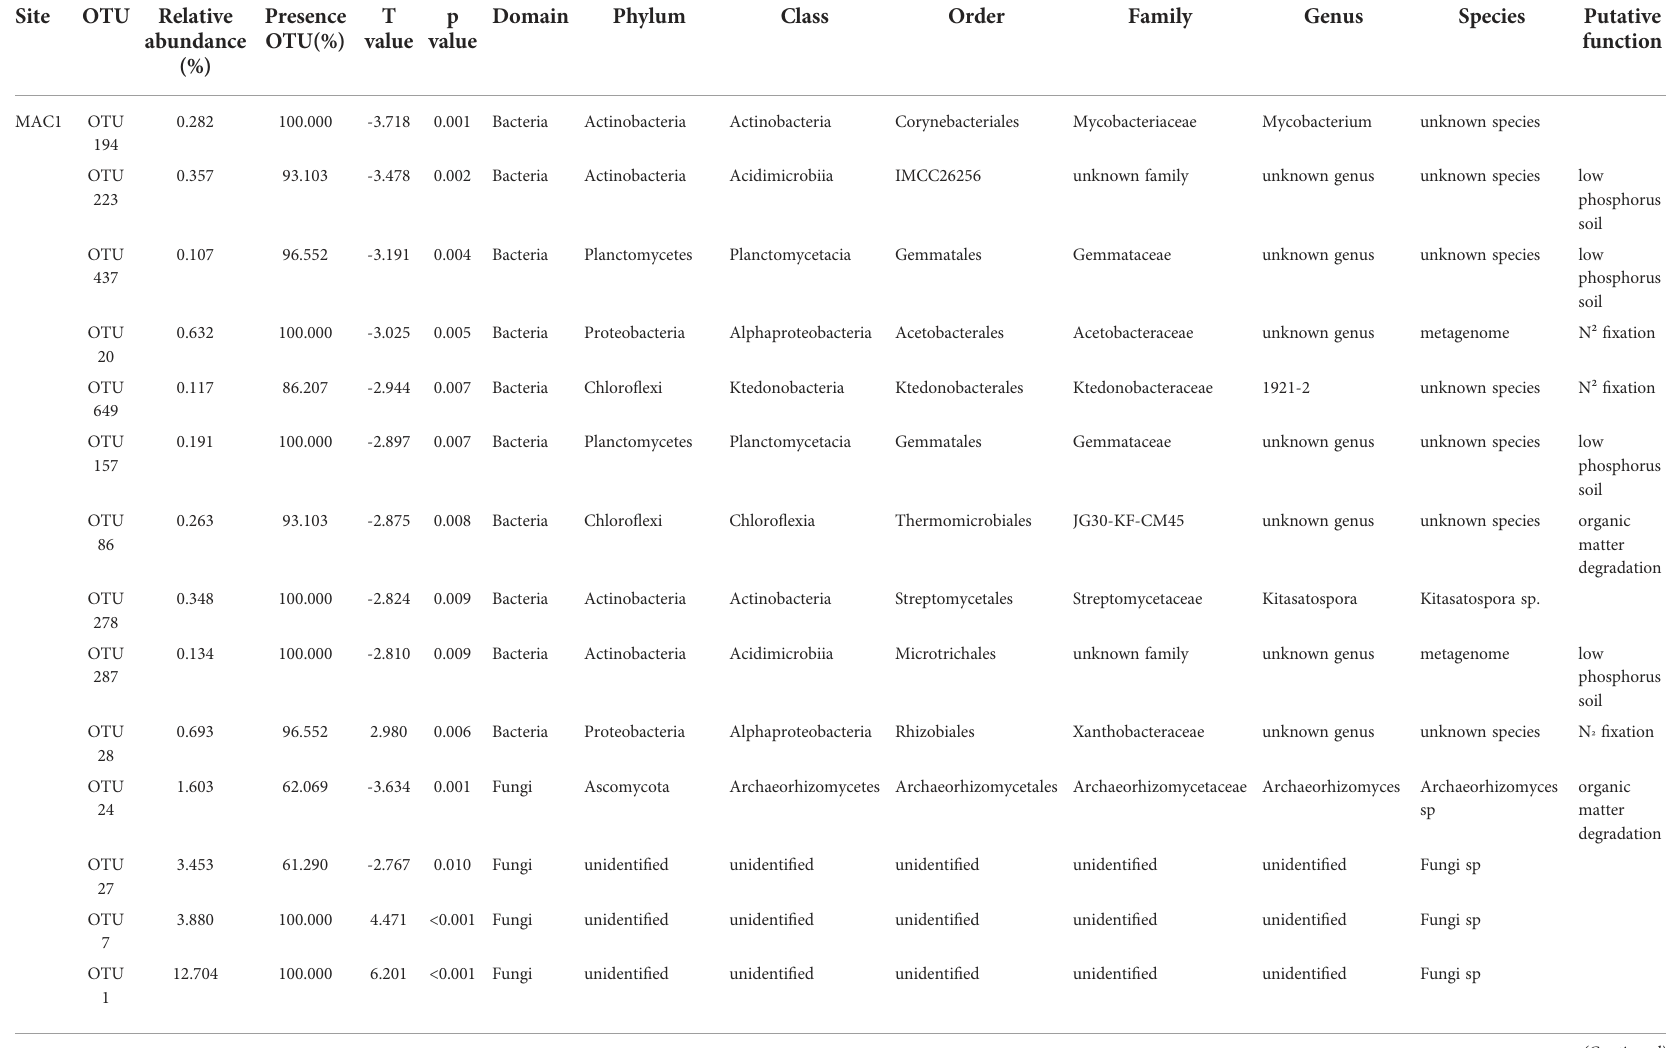
TABLE 2 Rhizospheric bacterial and fungal OTUs presenting signi fi cant ( a = 0.01) Pearson correlation between their relative abundance and the necrotic extent of the corresponding plant. OTUs detected in 60 % and 85 % of the samples for fungi and bacteria, respectively, with a mean relative abundance per site higher than 0.1 % are presented. Their taxonomy from the closest Blast sequence is indicated. For bacteria, N= 16, 10, 142, 5 and 71 for MAC1, LON30, AUS25, PJDA2 and PJDA6, respectively. For fungi N= 7, 3, 35 for MAC1, AUS25 and PJDA6,